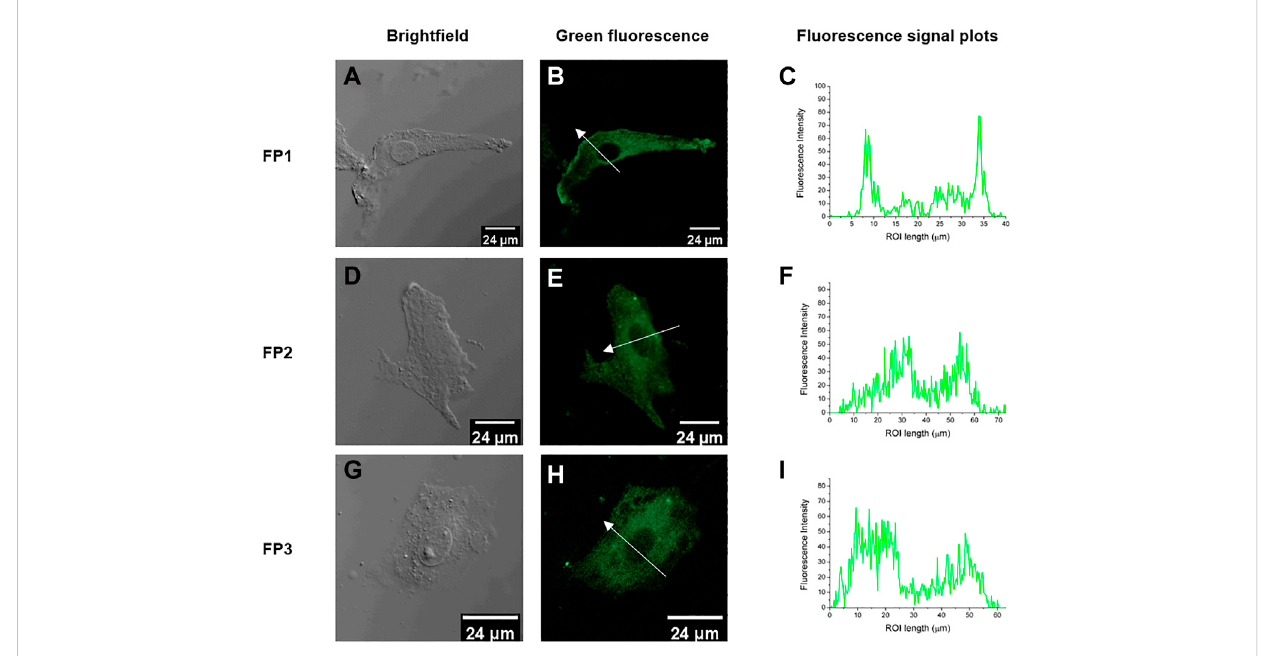
FIGURE 3 Fluorescence confocal images of living canine adipose-derived mesenchymal stem cells treated with probes FP1, FP2, and FP3 (10 μ M); (A, D, G) Bright fi eld images; (B, E, H) confocal images (green channel) of FP1 – FP3, respectively; (C,F, I) Fluorescence signal plots in the regions of interest (ROI) (white arrows in (B, E, H) . Green channel emission was collected at 490 – 550 nm, upon excitation at 488 nm.